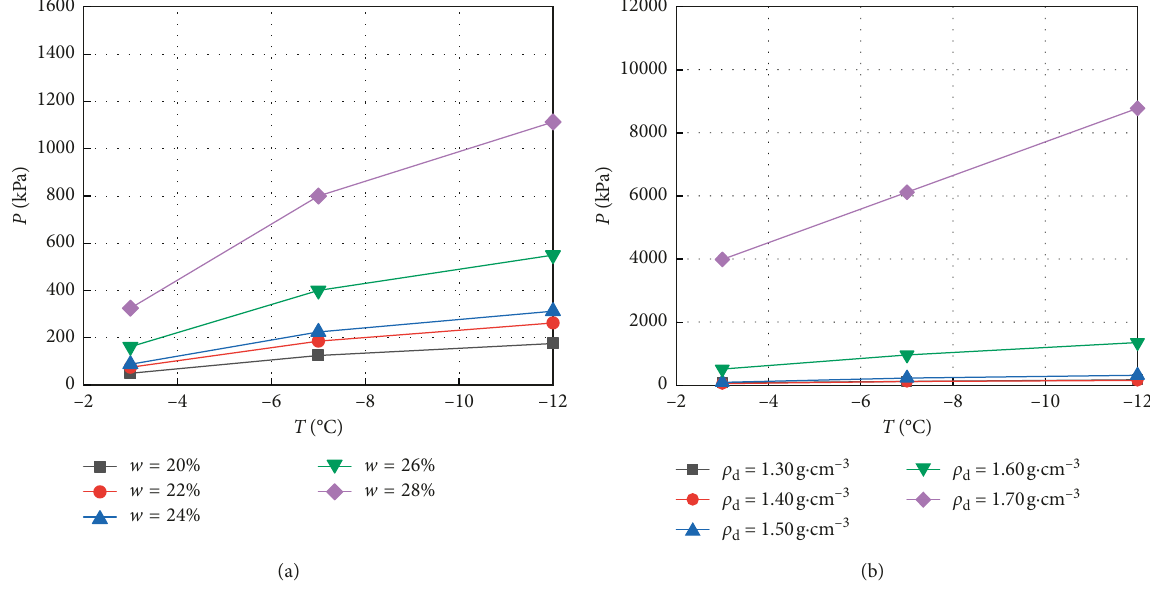
Figure 4: Relationship between temperature and frost-heave force. (a) ρ